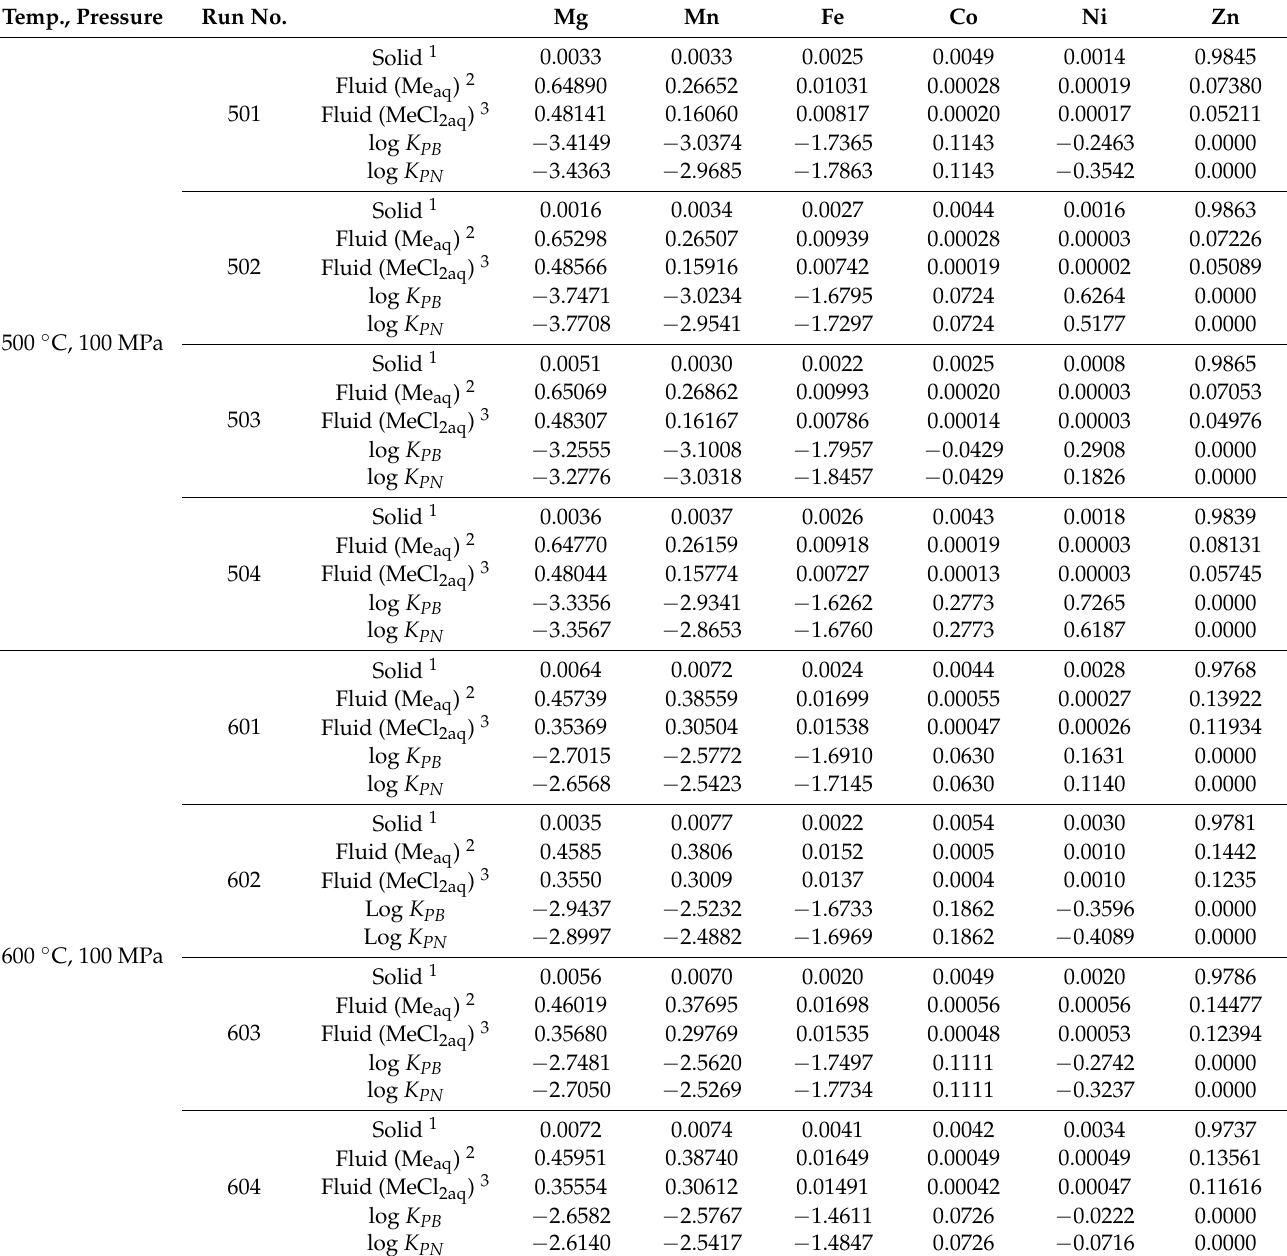
Table 2. Experimental results for ZnS–(Ni, Mg, Co, Fe, Mn)Cl 2 –H 2 O system at 500–800 ◦ C and 100 MPa. Temp.,